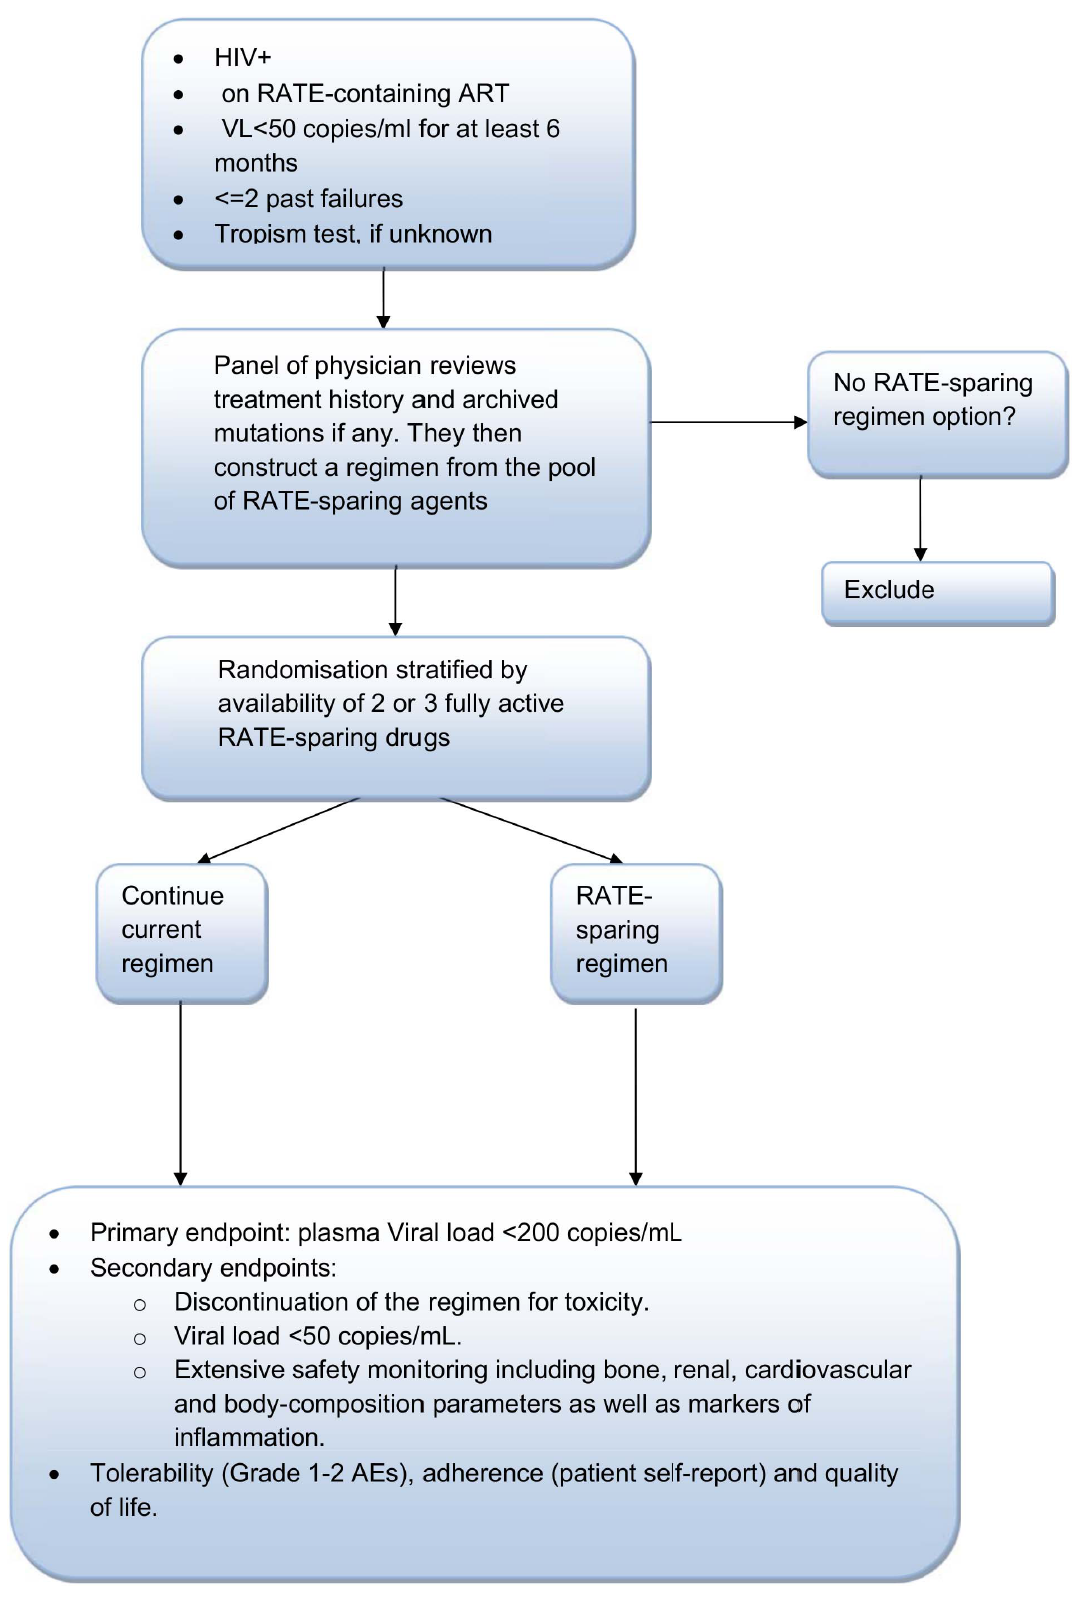
Figure 1. Proposed trial for evaluating RATE-sparing options.